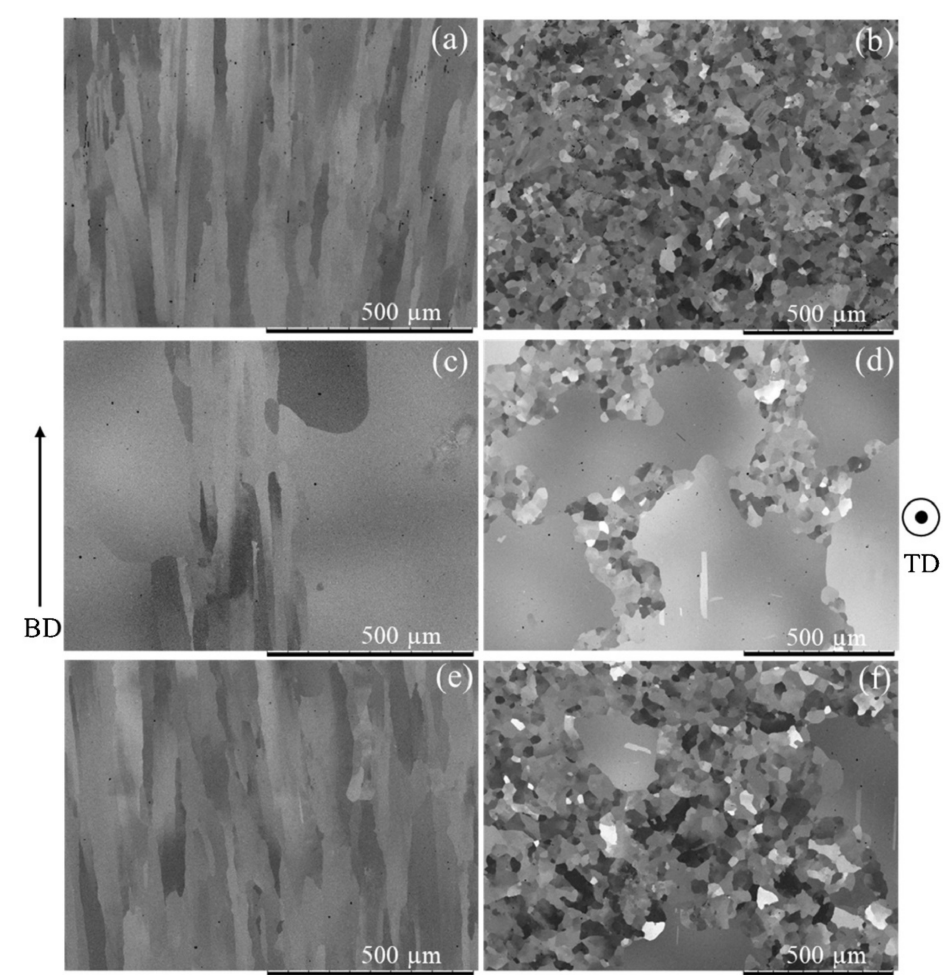
Figure 2. Schematic diagram of SEM micrographs. ( a , b ) as-built. ( c , d ) HIP. ( e , f ) HIP + HT treat- ments [75]. (Reprinted with permission from ref. [75]. Copyright 2019